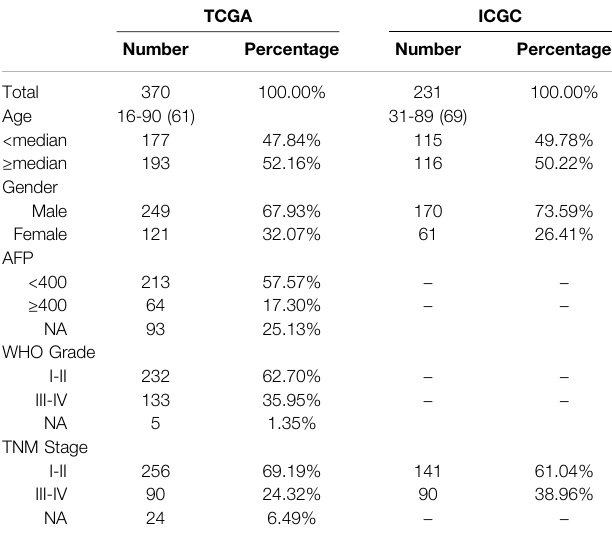
TABLE 1 | Clinicopathological features of the samples included in this